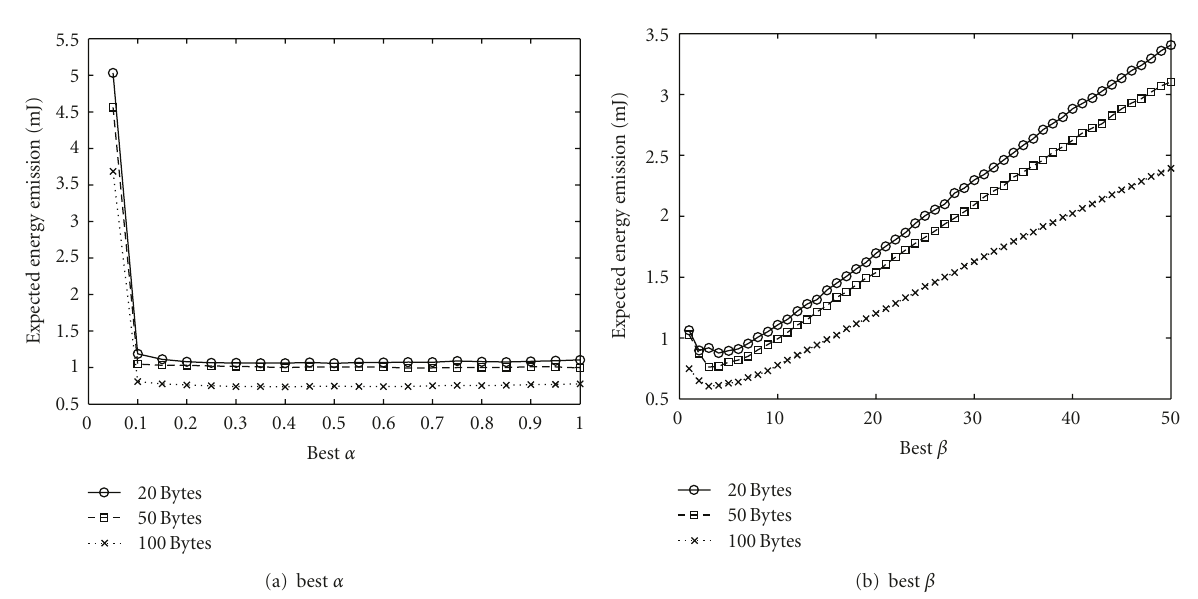
Figure 10: The best α and β for IEEE 802.15.4 with di ff erence